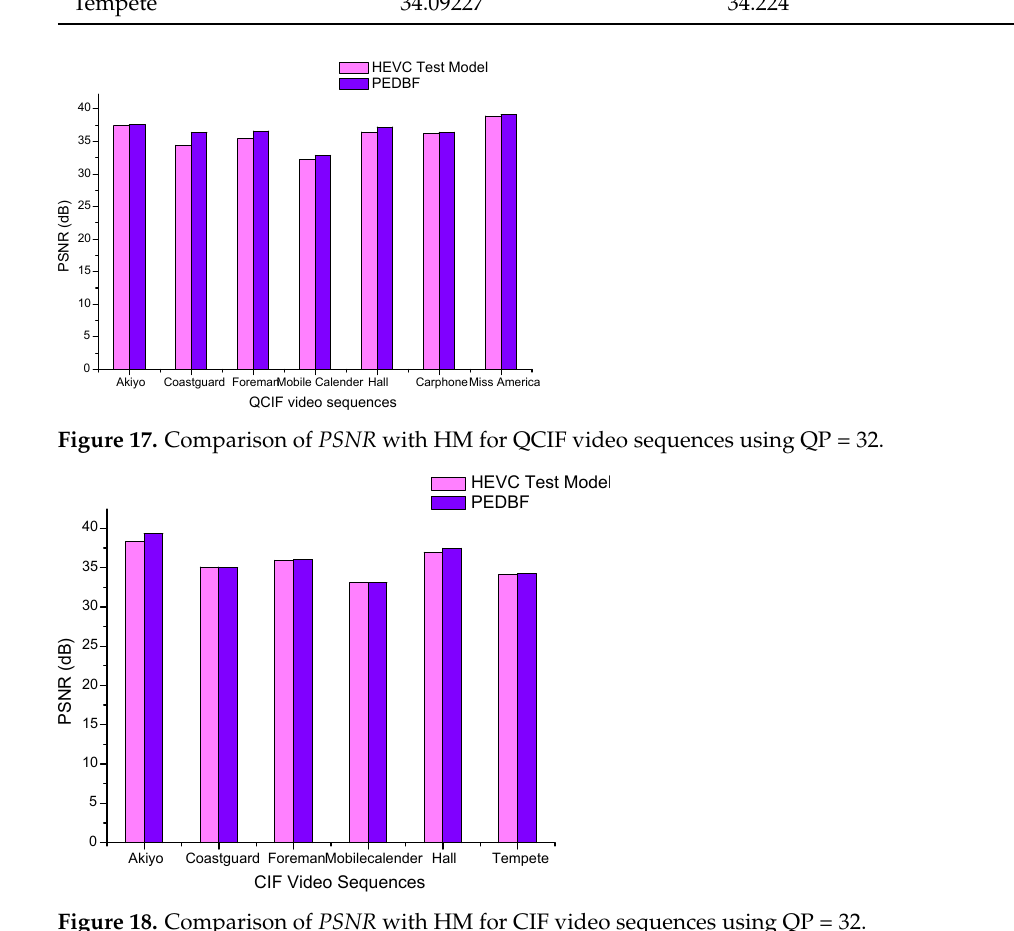
Figure 18. Comparison of PSNR with HM for CIF video sequences using QP =